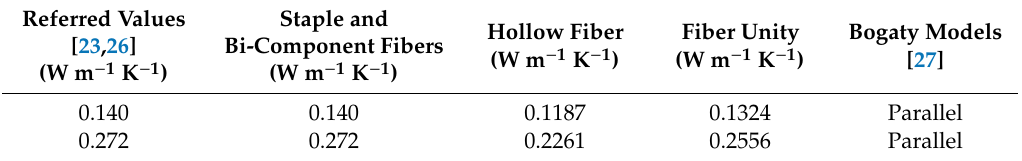
Table 5. Thermal conductivities of three fiber constituents and fiber unity.